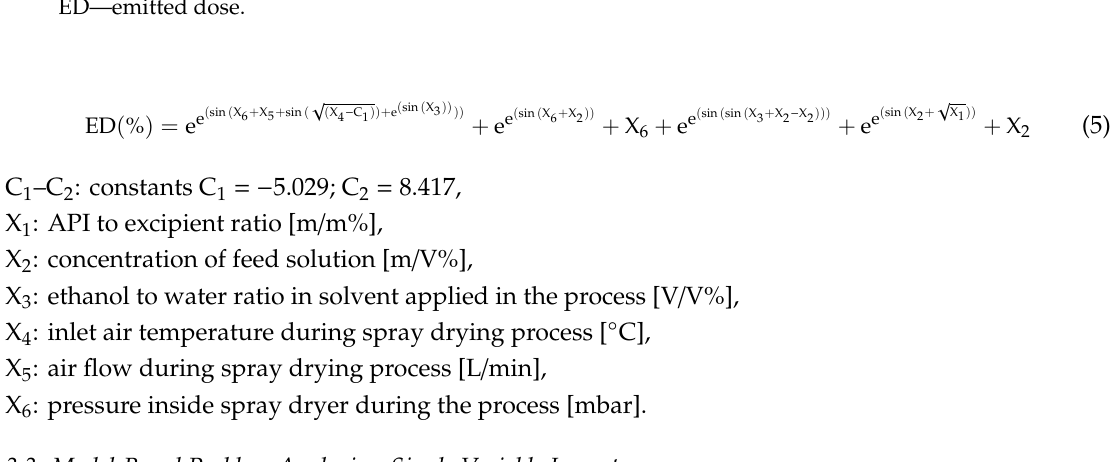
Figure 4. Comparison of ED values predicted by the model and obtained in laboratory experiments. ED—emitted dose.